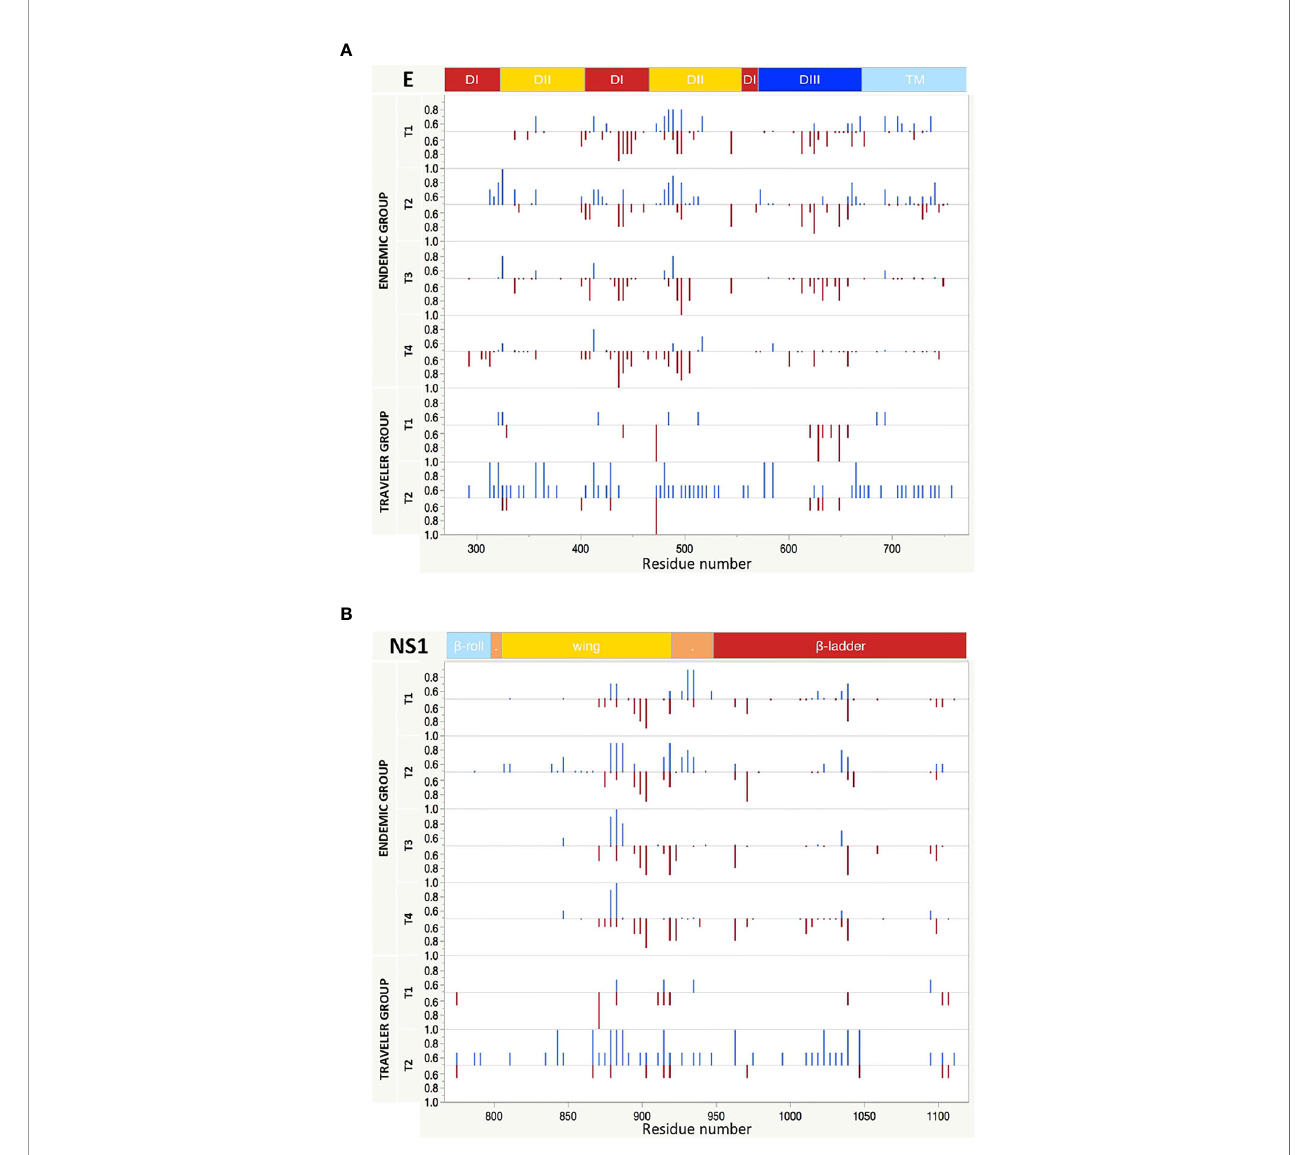
FIGURE 5 | Longitudinal IgG and IgM reactivity against E and NS1 proteins from DENV. The y axis indicates the fraction of endemic (n = 10) or traveler (n=3) patients reacting against peptides from E (A) and NS1 (B) proteins with either IgG (top, blue bars) or IgM (bottom, red bars) antibodies at the time points samples were collected. T1: acute, T2: early convalescent, T3: mid convalescent and T4: late convalescent samples. The x axis indicates the proteomic coordinates (amino acid start position) according to DENV Uniprot ref: P33478. The protein domains for E and NS1 are color represented at the top of each